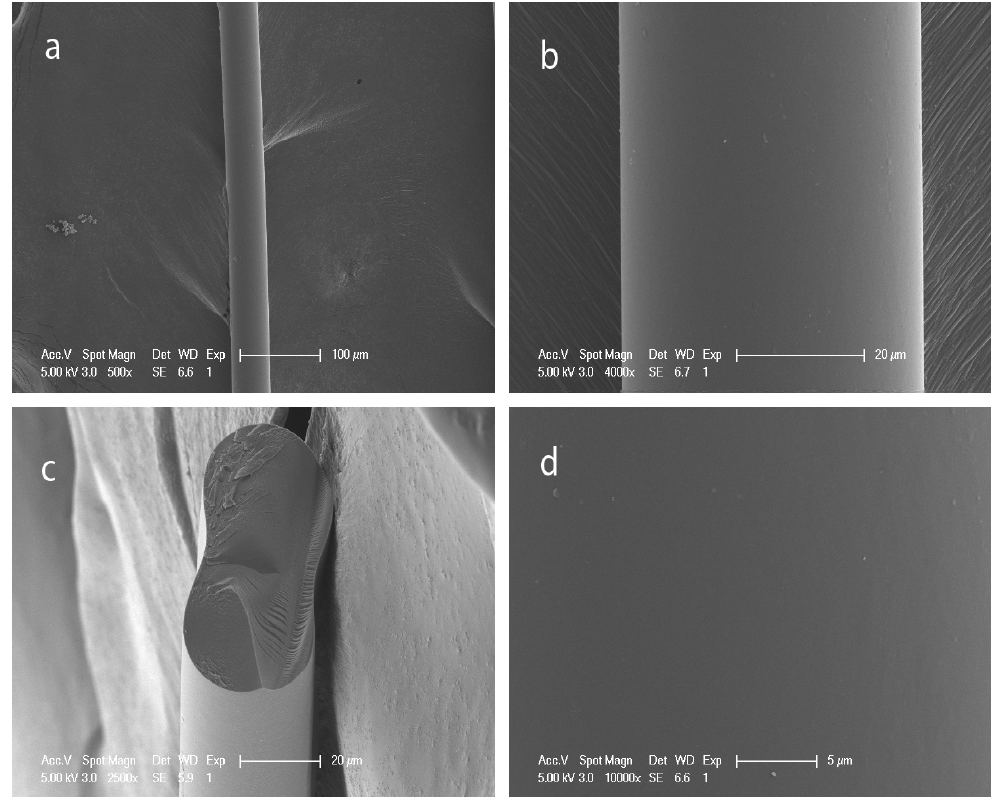
Figure 2. SEM photographs of PVA/SiO 2 -TiO 2 hybrid fiber. ( a ) and ( b ) of fiber appearance; ( c ) and ( d ) of the cross-section of